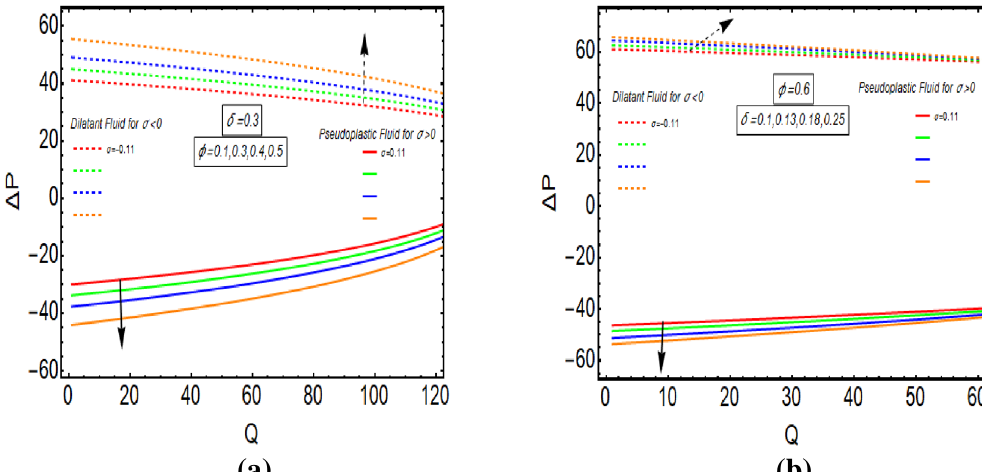
Figure 5. ( a ) Pressure rise for ϕ with σ > 0 and σ < 0 . ( b ) Pressure rise for δ with σ > 0 and σ < 0.